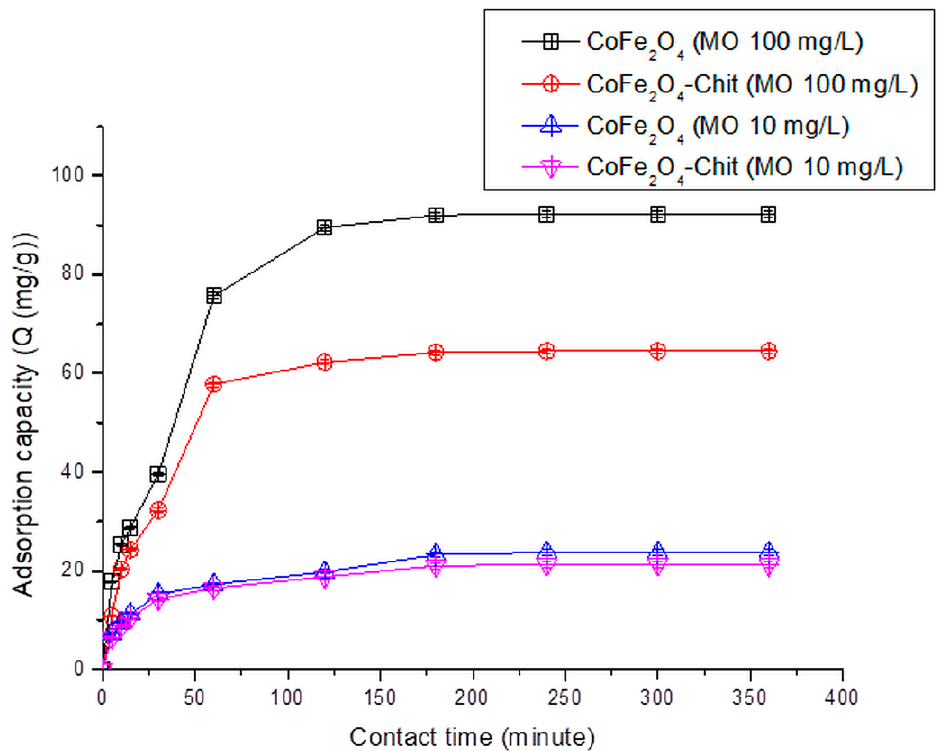
Figure 13. The variation of CoFe 2 O 4 /CoFe 2 O 4 –Chit adsorption capacity versus contact time at pH = 2.22 for the MO adsorption process (pH = 2.22).